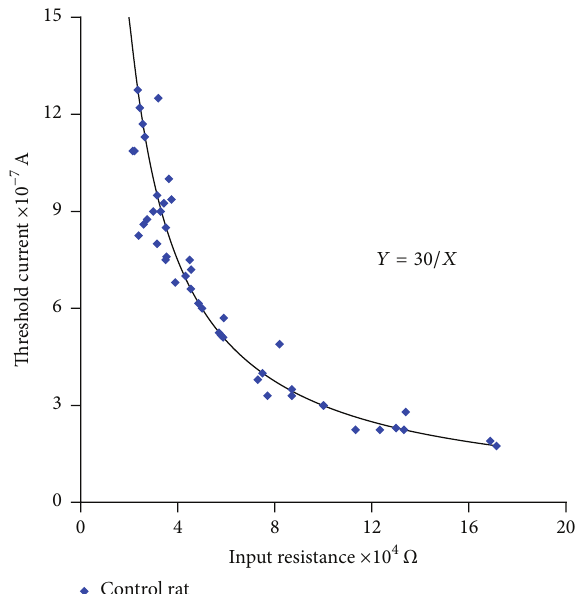
Figure 5: Fit relationship of the experimental input resistance- current threshold values (blue) with respect to the theoretical curve (black). Values obtained in the cells of the papillary muscle of the heart of the control rats. The continuous curve corresponds to an equilateral hyperbola defined by the equation 𝑌 = 𝐾/𝑋 , where 𝐾 = 30 mV. For each input resistance value, there is a corresponding threshold current value adequately conforming to the theoretical curve, which is established by the statistical analysis of 𝑅 2 = 0.92 and 𝑝 < 0.05 .